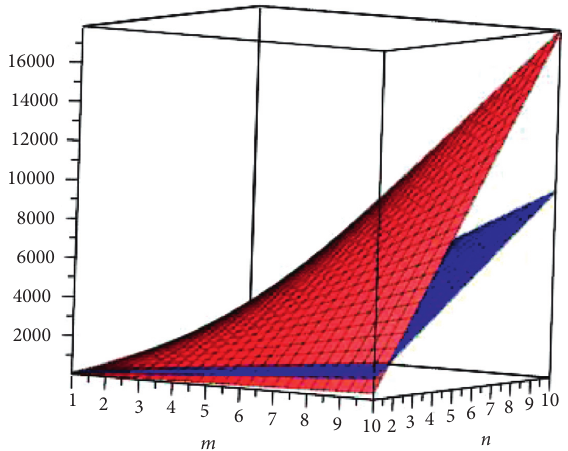
( P + Figure 6: Graph for ( α � 2 ) mn ( 2 . 12 2 + 2 . 8 2 + 3 . 4 2 ) − m ( 12 2 + n α